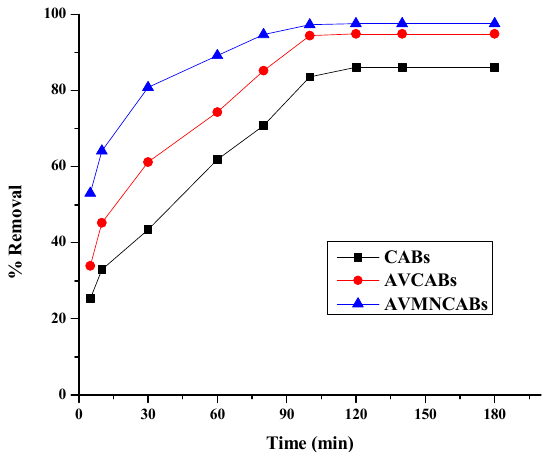
Figure 11. Effect of time on the removal of Cu(II) (10 μ g mL − 1 Cu(II), 0.2 g adsorbent; 30 °C, pH 4).